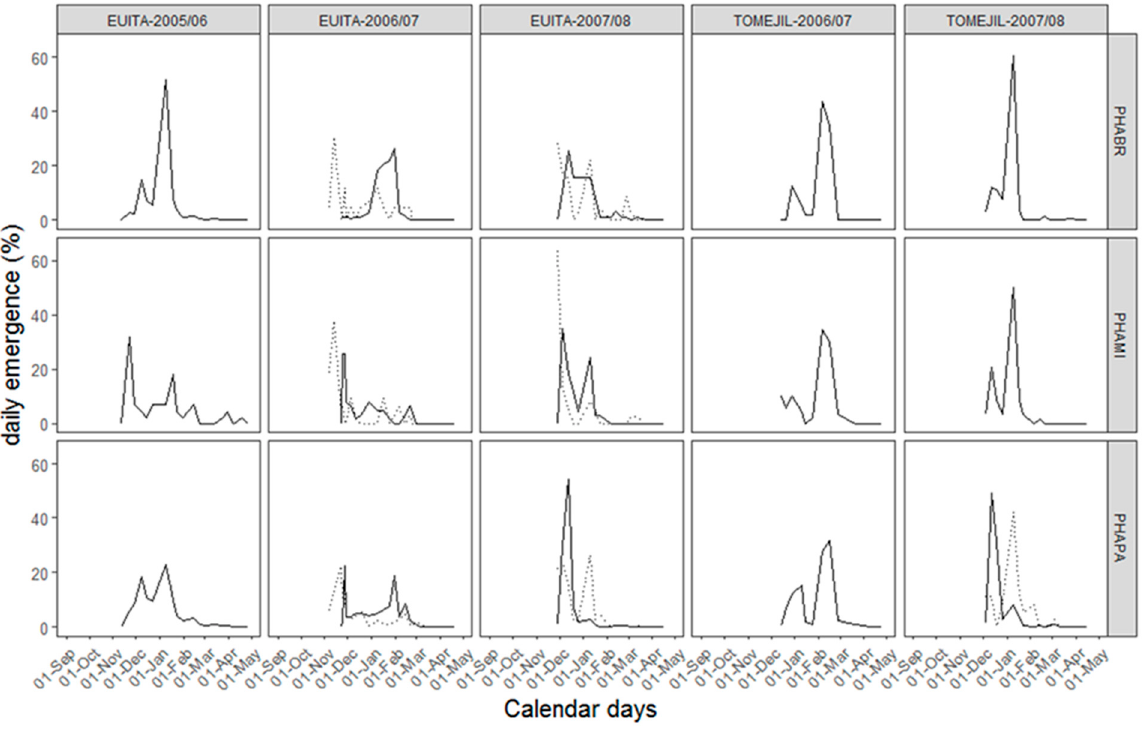
Figure 2. Daily emergence of the three Phalaris species at the two experimental locations. Black lines—first season emergence (sowing season); dotted lines—second season emergence (from the remaining seed bank). PHABR: Phalaris brachystachys ; PAHMI: P. minor ; PHAMPA: P. paradoxa .